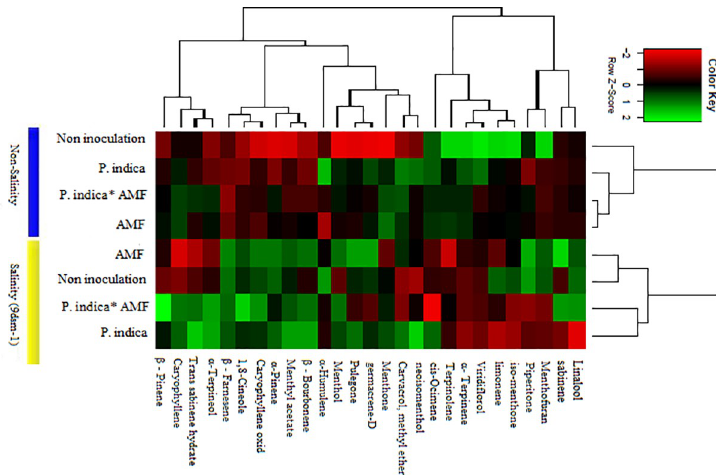
Fig 11. Heatmap pattern of the essential oil constituents from peppermint. AMF–Mycorrhizae treatment; P . indica � AMF– P . indica and Mycorrhizae